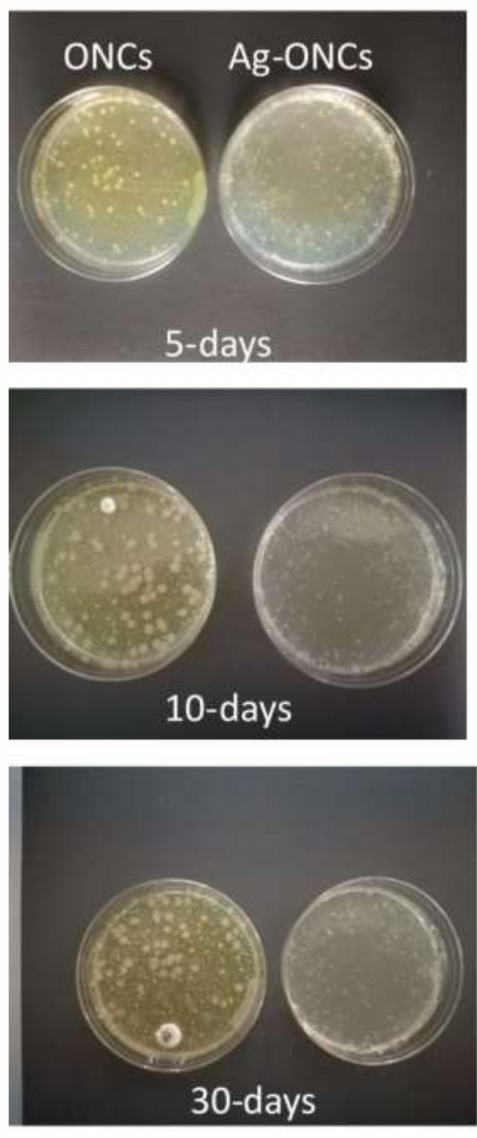
Figure 5. Comparison between ONCs and Ag–ONCs’ antibacterial properties after different incuba- tion times. Petri dishes are stored at room temperature under natural